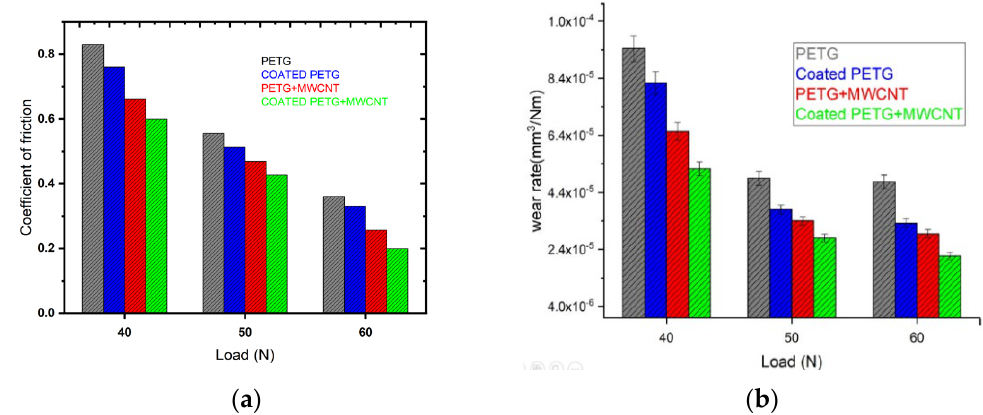
Figure 14. ( a ) Wear rate at different loads; ( b ) coefficient of friction at different loads.